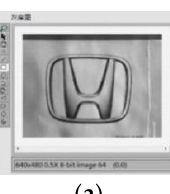
Figure 9. Process of preprocessing and vehicle logo recognition.